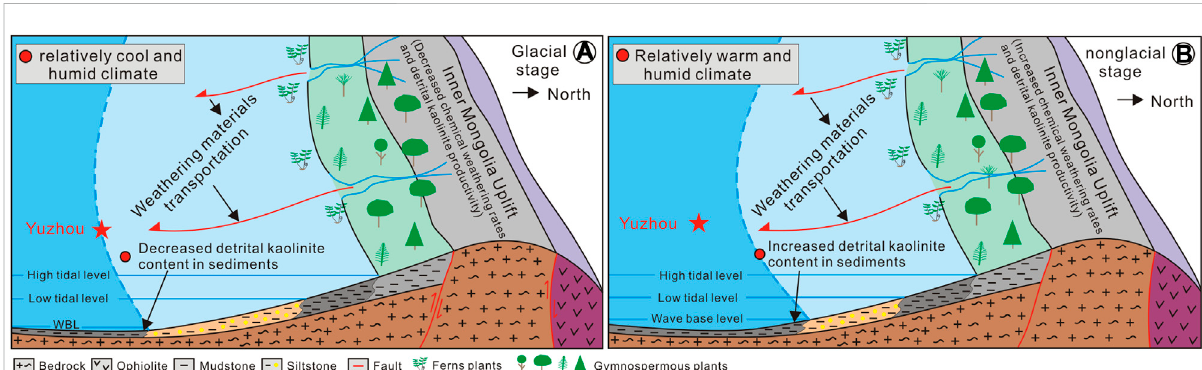
FIGURE 11 Conceptual model for the formation of detrital kaolinite in North China. (A) Glacial stage: decreased chemical weathering rates and detrital kaolinite productivity in provenance area, and limited weathering materials transportation led to the content of detrital kaolinite decreased in sediments. (B) Nonglacial stage: increased chemical weathering rates and detrital kaolinite productivity in provenance area, and extensive weathering material transportation led to the content of detrital kaolinite increased in sediments. Abbreviations: WBL = wave base